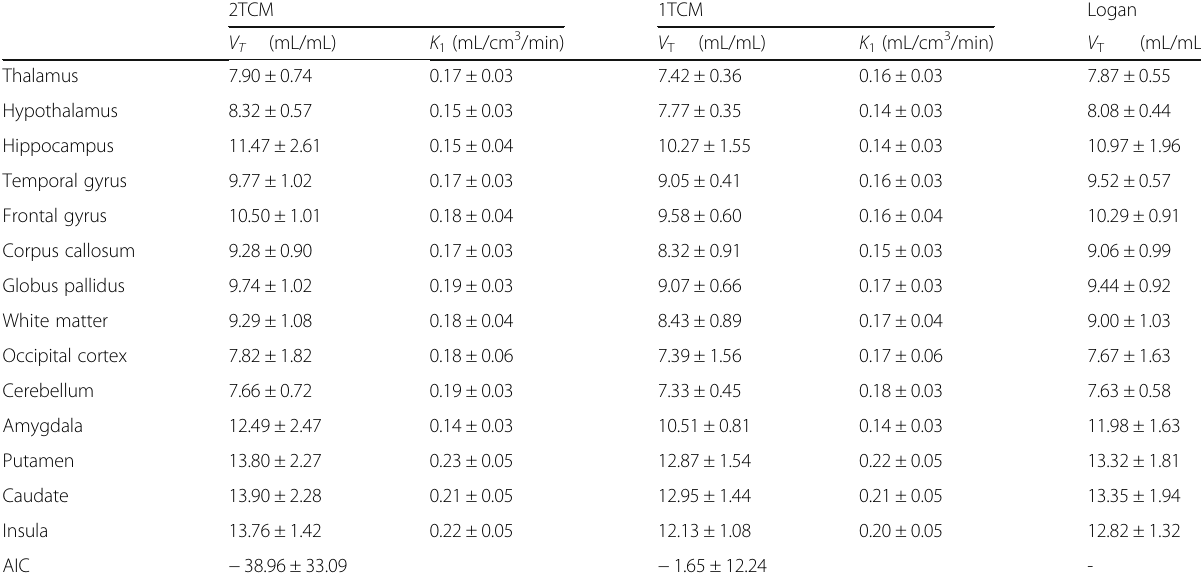
Table 2 Estimated parameters from baseline scan of three baboons using different compartmental models